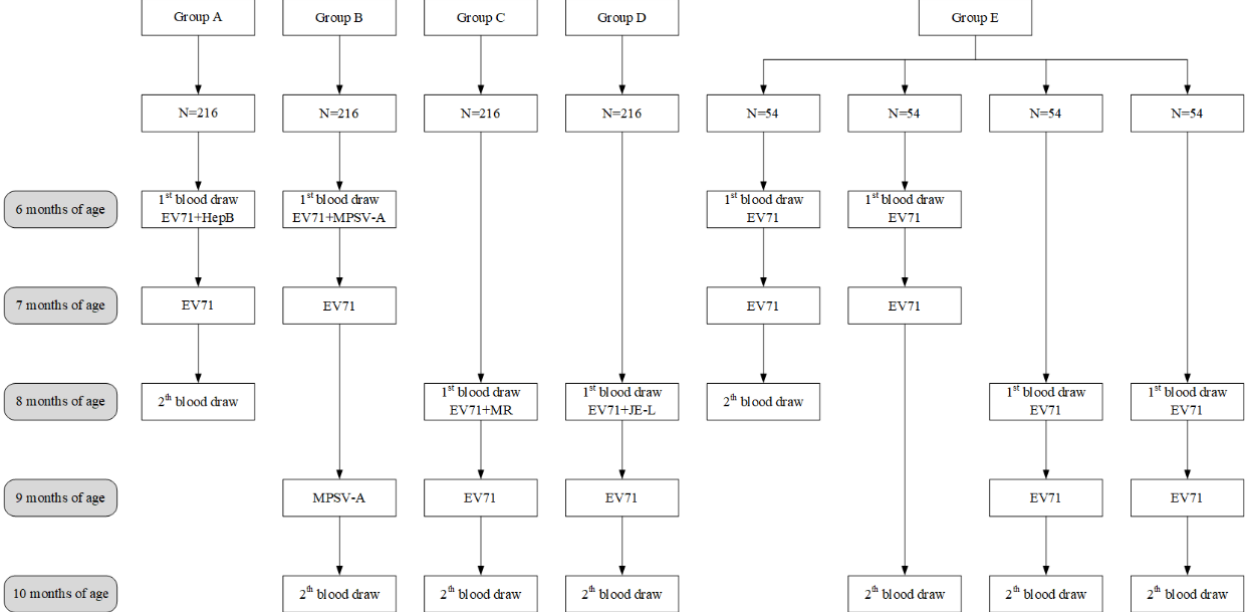
Figure 1. Flowchart of blood drawing and vaccinations in five study groups. Group A: EV71 vaccine and hepatitis B virus vaccine simultaneous administration group; Group B: EV71 vaccine and group A meningococcal polysaccharide vaccine simultaneous administration group; Group C: EV71 vaccine and measles-rubella combined vaccine simultaneous administration group; Group D: EV71 vaccine and Japanese encephalitis vaccine simultaneous administration group; Group E: EV71 vaccine separate administration group. EV71 = Inactivated enterovirus 71 vaccine; HepB = Hepatitis B virus vaccine; MPSV-A = Group A meningococcal polysaccharide vaccine; MR = measles-rubella combined vaccine; JE-L = Live, attenuated Japanese encephalitis